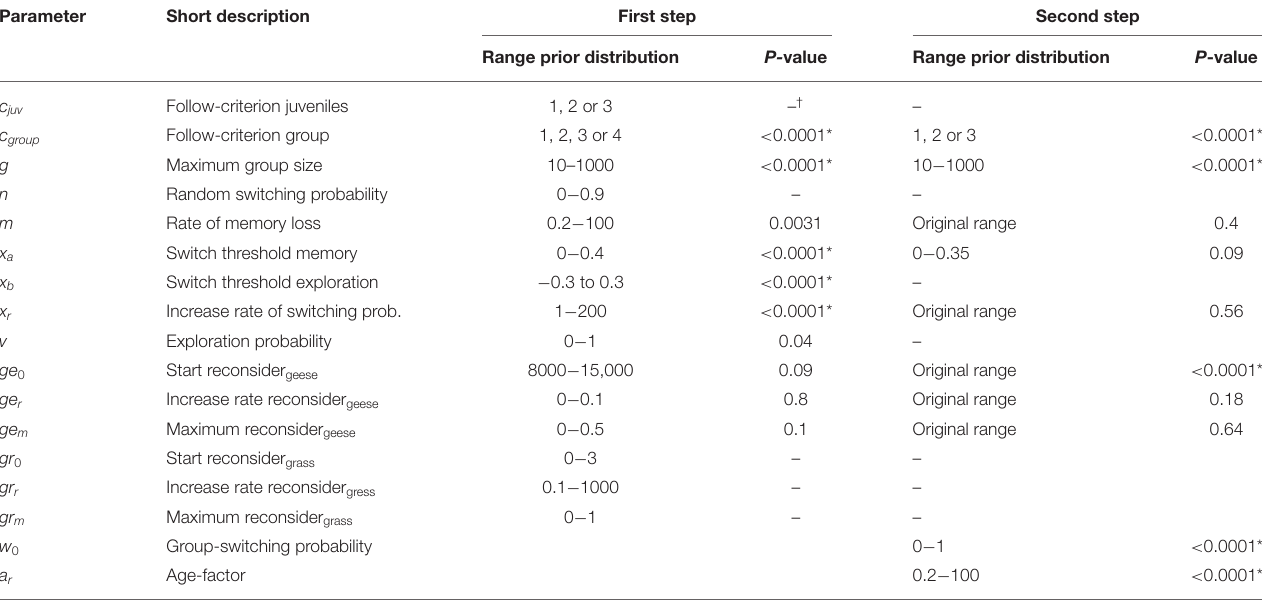
TABLE 3 | Significance test of parameter distributions in selected